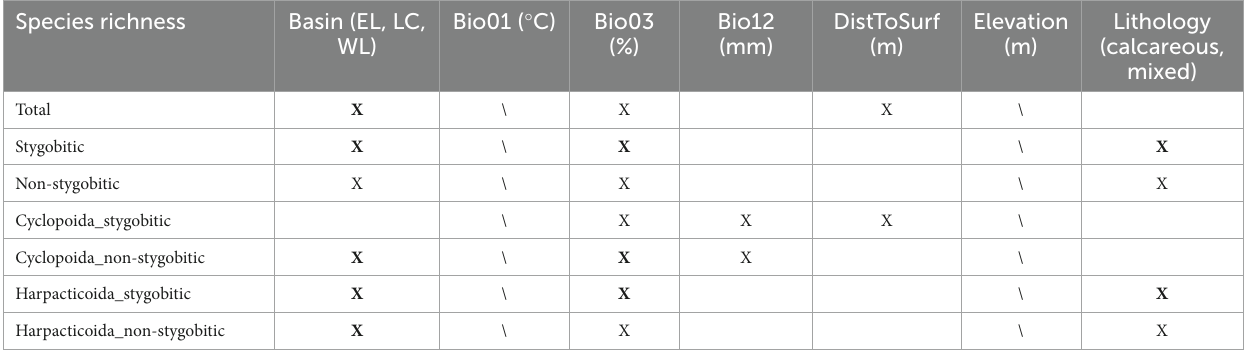
TABLE 1 The explanatory variables selected to fit the initial Generalized Linear Model (i.e., prior to the backward variable selection) for each of the alpha diversity dimensions (i.e., total species richness, richness of stygobites, richness of non-stygobites etc.) are indicated with “X”.